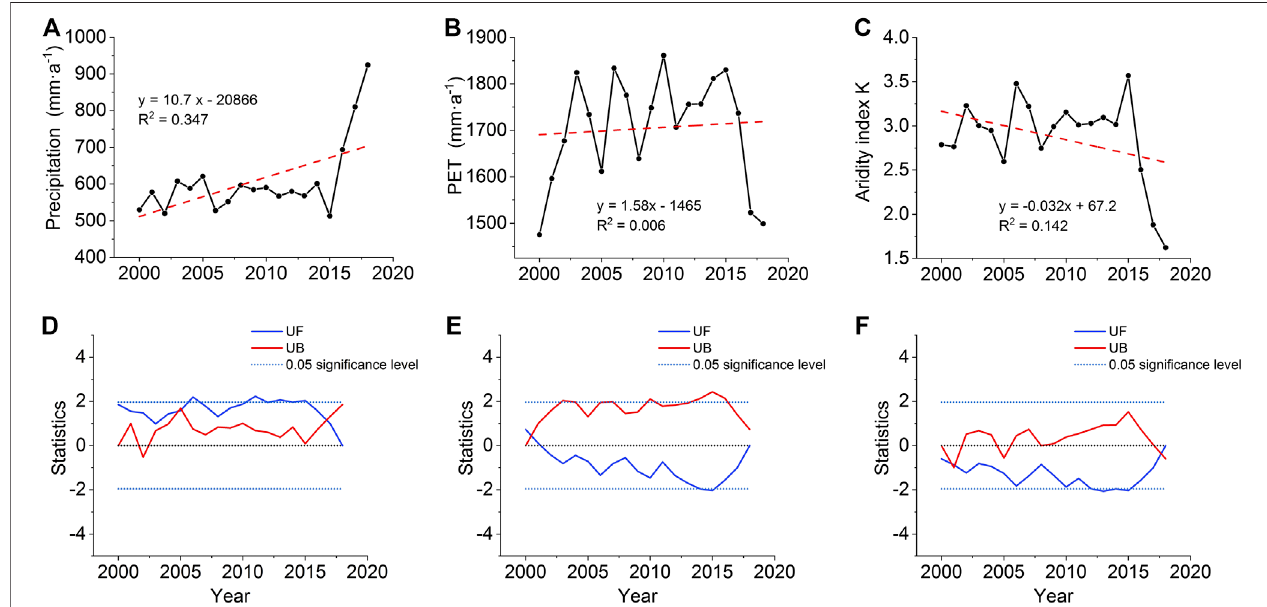
FIGURE 6 | Variation trend and the Mann-Kendall test of annual precipitation (A,D) , PET (B,E) and aridity index K (C,F) in the TRH region from 2000 to 2018.